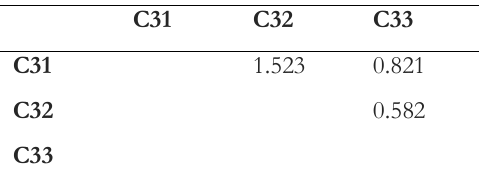
Table 8. Pairwise comparisons of smart marketing sub-criteria.